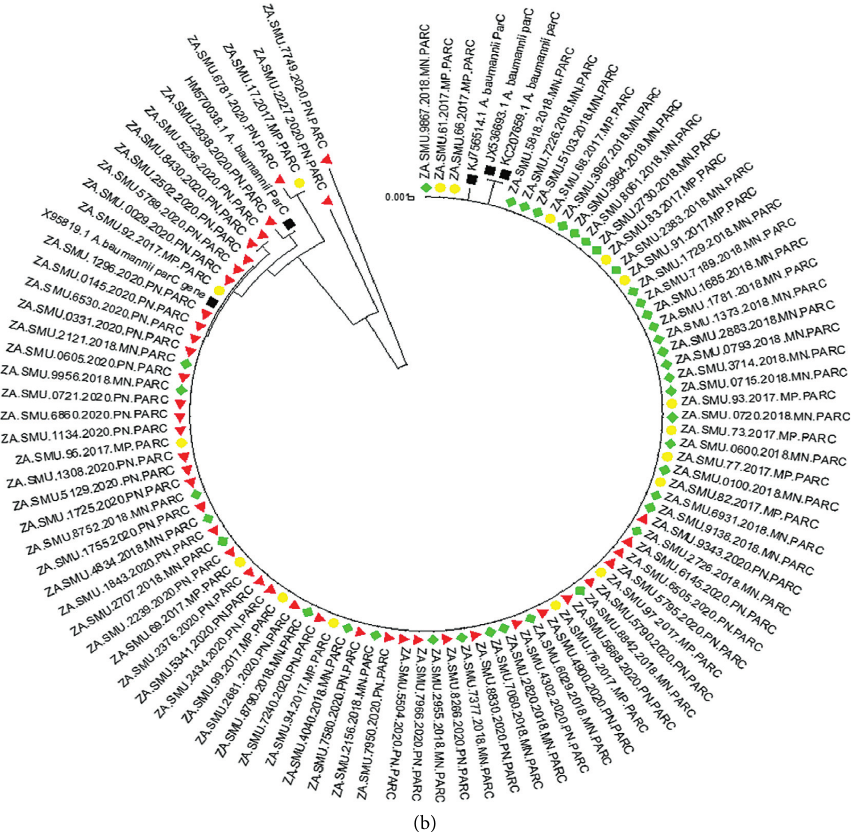
Figure 4: (a) Phylogenetic analysis of the gyrA gene sequences showing highly related strains. The evolutionary history was inferred using the neighbour-joining method [48]. (b) Phylogenetic analysis of the parC gene sequences showing highly related strains. The evolutionary history was inferred using the neighbour-joining method